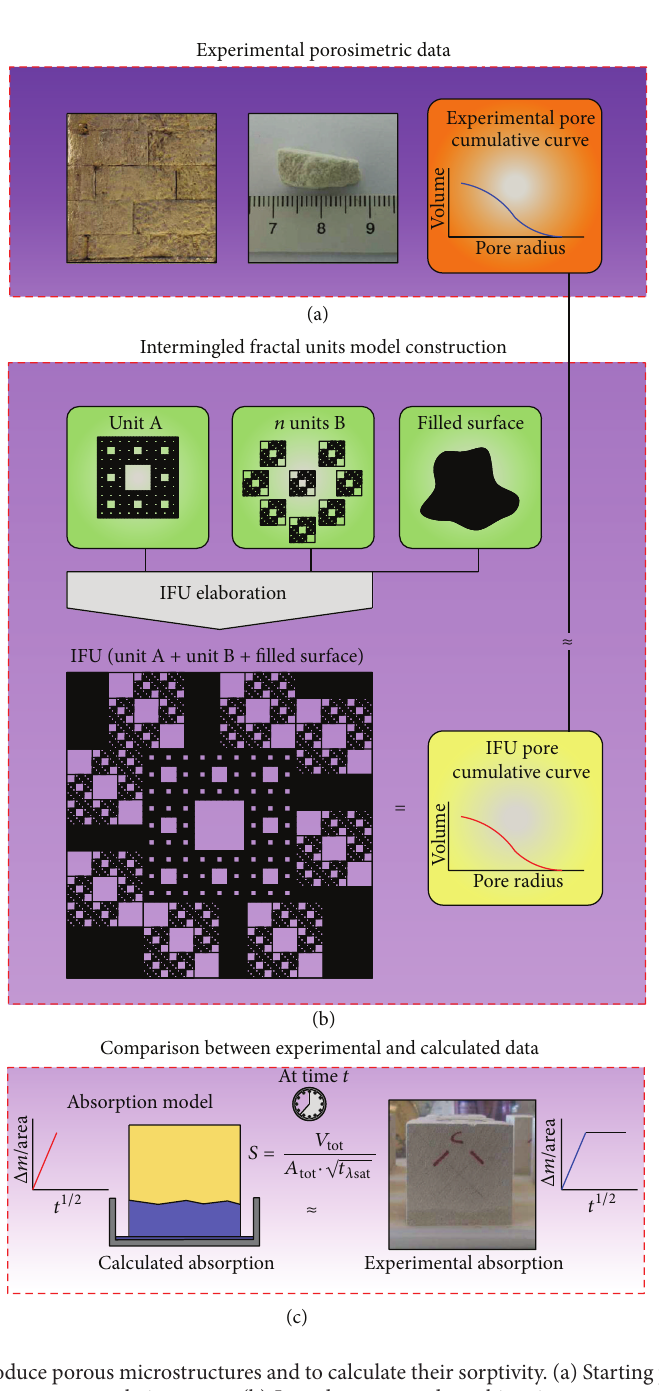
Figure 2: IFU procedure to reproduce porous microstructures and to calculate their sorptivity. (a) Starting point is represented by MIP tests and consequent mercury intrusion pore cumulative curve. (b) In order to reproduce this microstructure, two elementary units, based on Sierpinski carpet, and a portion of filled surface are used. After having compared experimental and IFU curves, IFU model is broken down again in the base units, and the analytical procedure is applied. (c) The calculated IFU sorptivity ( 𝑆 IFU ) can be compared with the data acquired experimentally ( 𝑆 exp